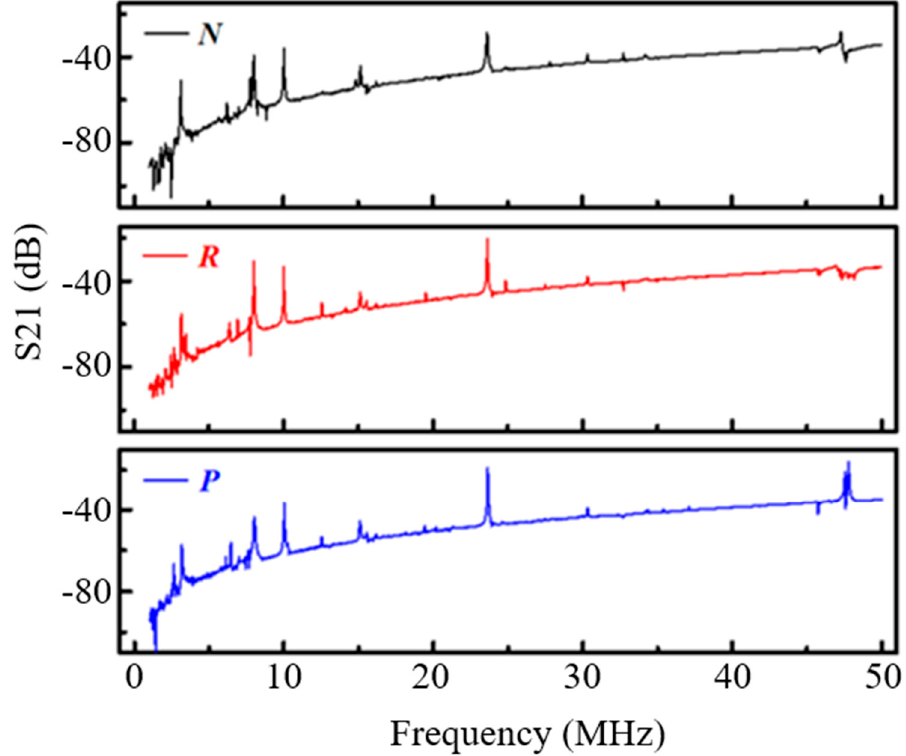
Figure 9. Broadband S21 curve of the resonator, N is the traditional structure, R is the mirror structure,